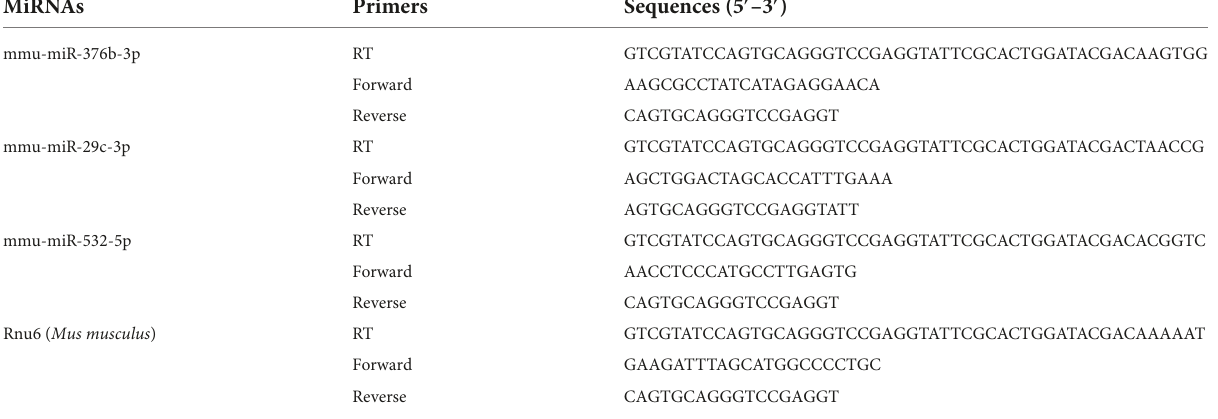
TABLE 1 The miRNA